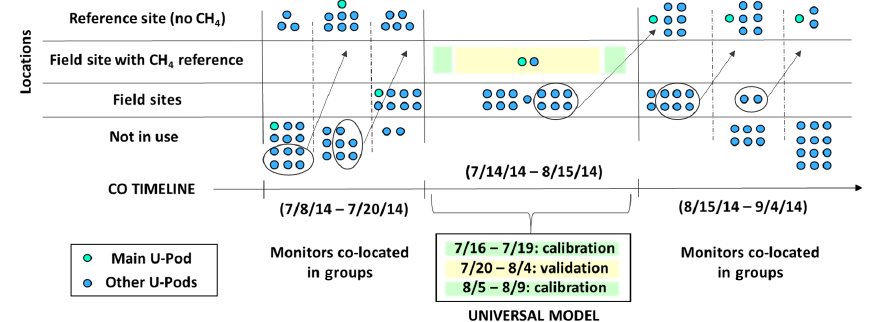
Figure 4. Timeline for Colorado, indicating when monitors were co-located together in batches before and after the field deployment and il- lustrating how two U-Pods were sited with a reference instrument during the field deployment (these data were used for calibration generation or training data versus model validation or testing data).